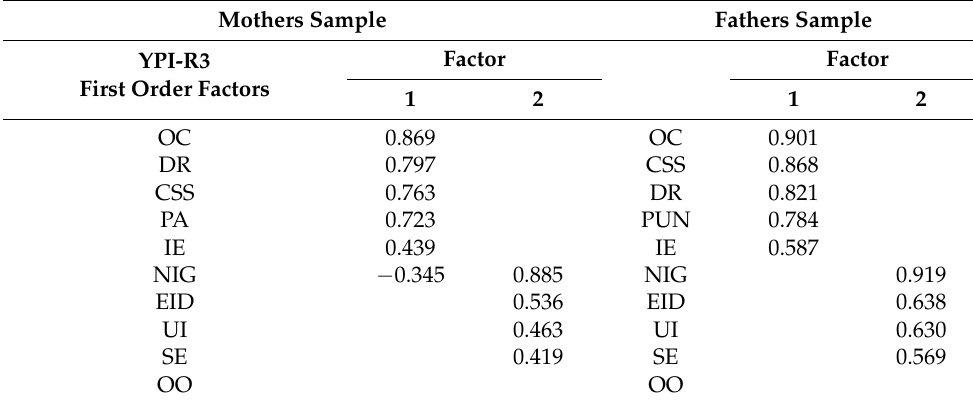
Table 4. Two-Factor Solution for YPI-R3 using Singapore Mothers and Fathers Sample.